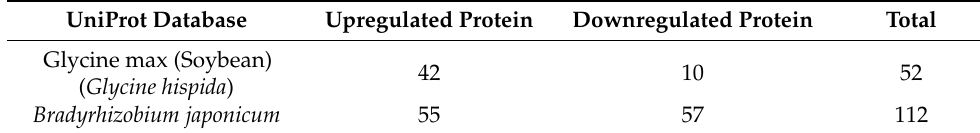
Table 2. Differential protein identification results of dual-root soybean